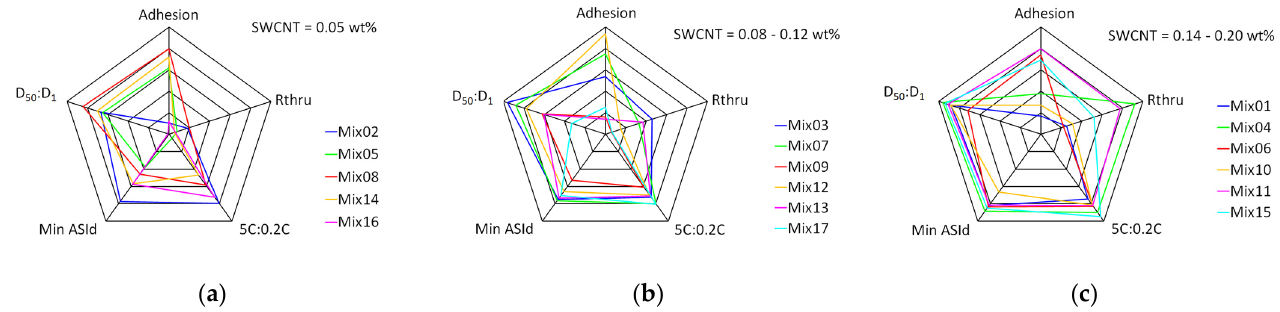
Figure 7. Spider plots for mixes with different carbon nano-tube contents, ( a ) low, ( b ) intermediate, and ( c ) high.